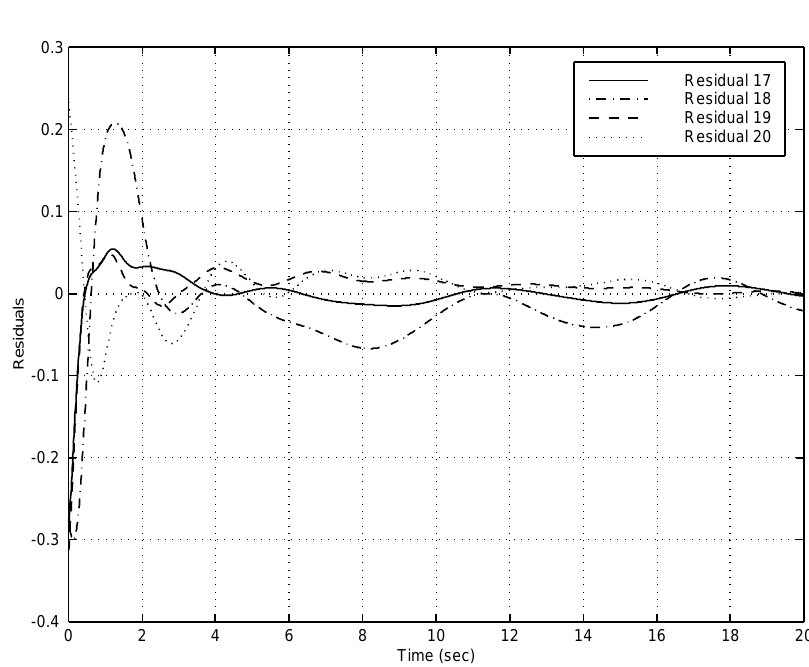
Fig. 8. Residuals 17-20 for 12 mode simulation with δ 1 = 0 . 005